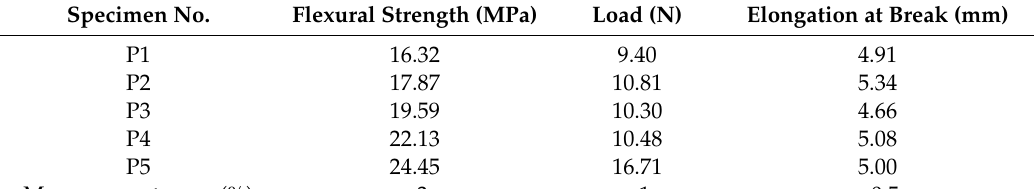
Table 9. Flexural test results for MUF-ENB specimens, cured at 80 °C for 2 h, according to method 5. Specimen No.